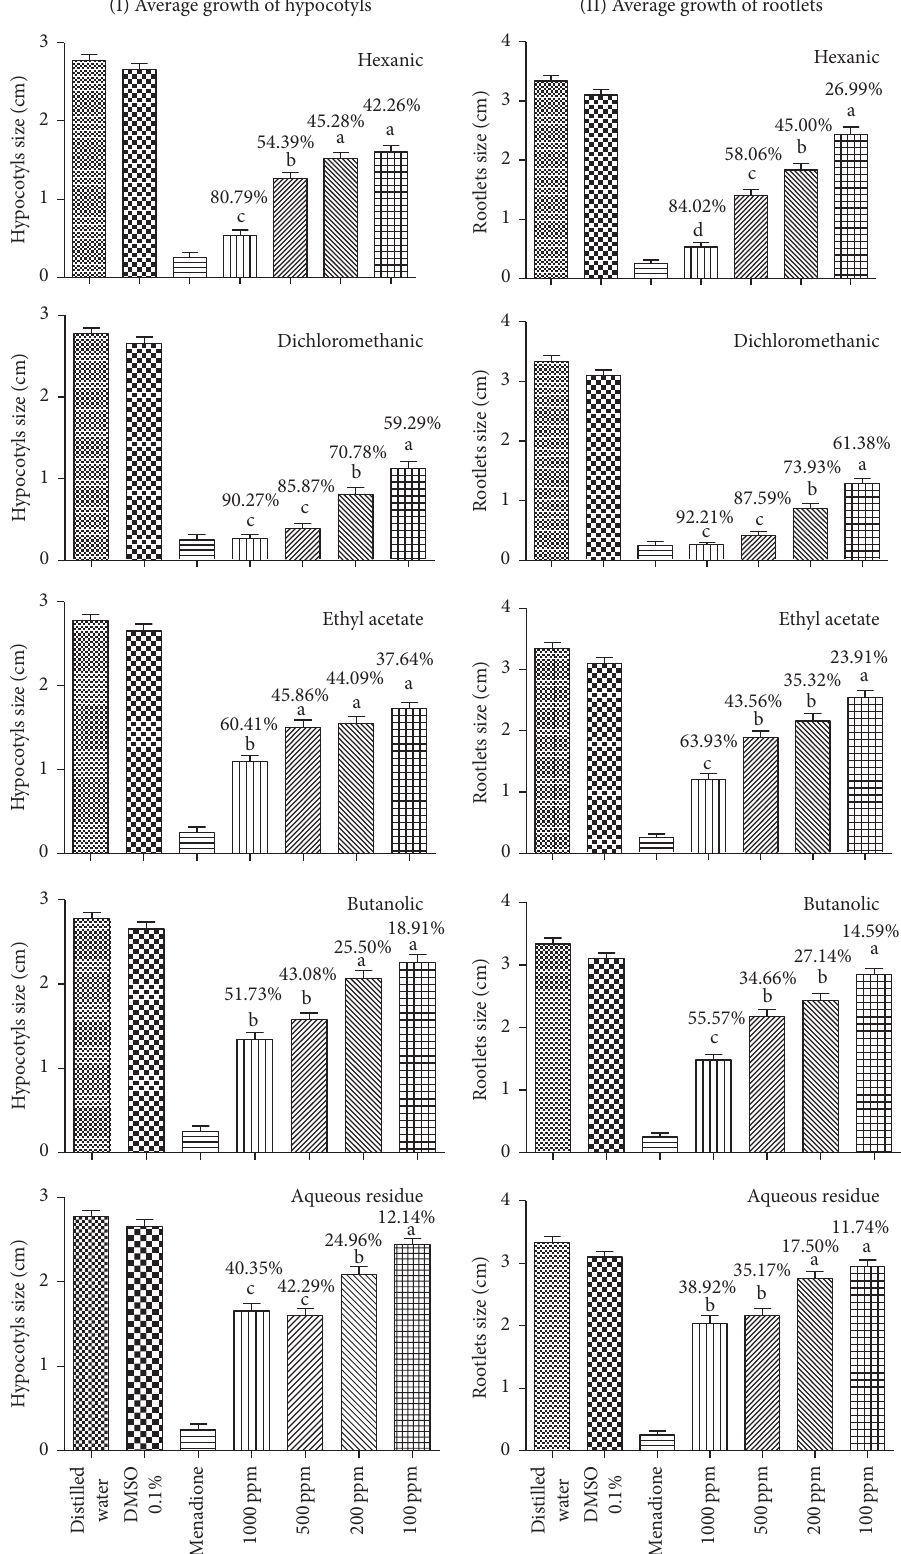
Figure 2: Evaluation of allelopathic activity of partitions of seed extracts of Arachis hypogaea (cultivar BR-1) on the growth of hypocotyls and rootlets of L . sativa based on the average lengths of each partition and the inhibition percentages are relative to distilled water control. The same letter means no statistically significant difference between the samples in each graphic, according to Tukey’s